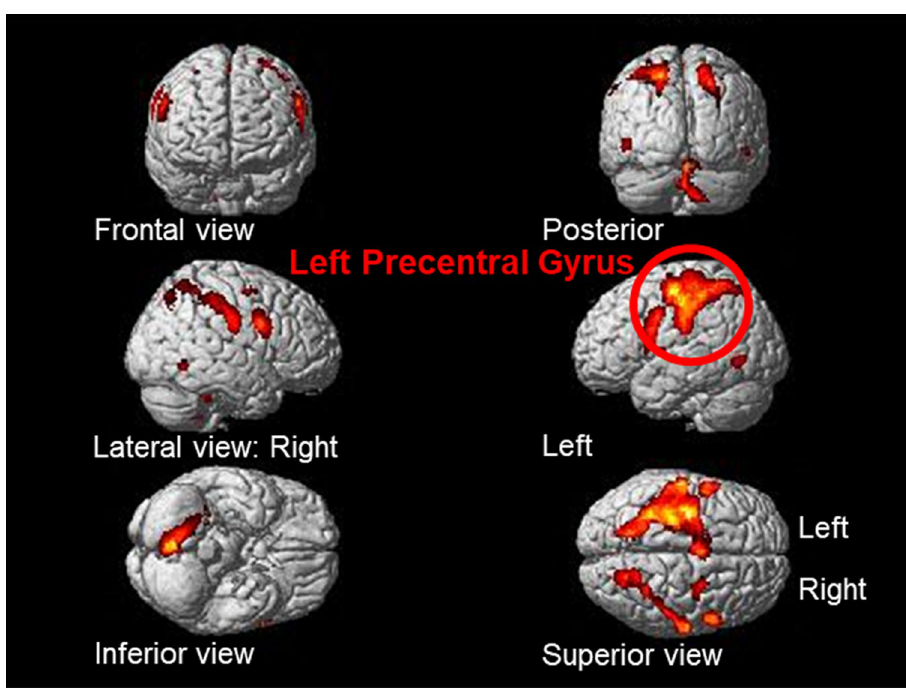
Fig 6. Brain activation for copy drawing (A2) versus viewing (A1).